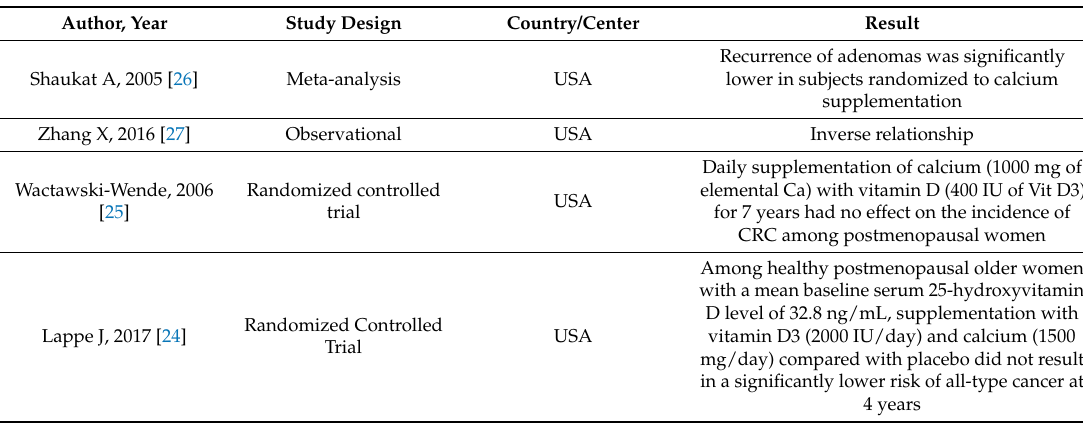
Table 4. Summary of major epidemiological studies examining the association of Calcium intake with